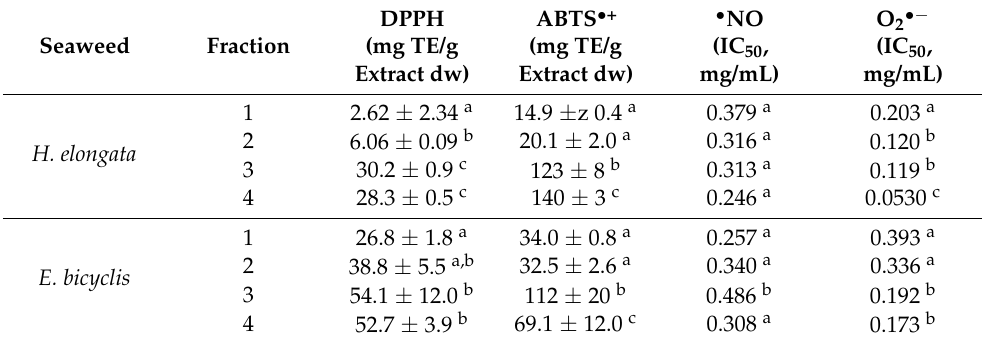
Table 3. Scavenging activity of Himanthalia elongata (L.) S.F.Gray and Eisenia bicyclis (Kjellman) Setchell fractions.